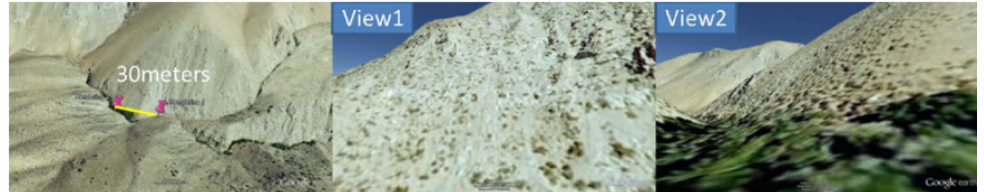
Figure 10. The intense change of the skyline in a mountainous area. Although View1 and View2 are only 30 m apart, the skyline along the same direction changes greatly due to the promixity of the mountains.